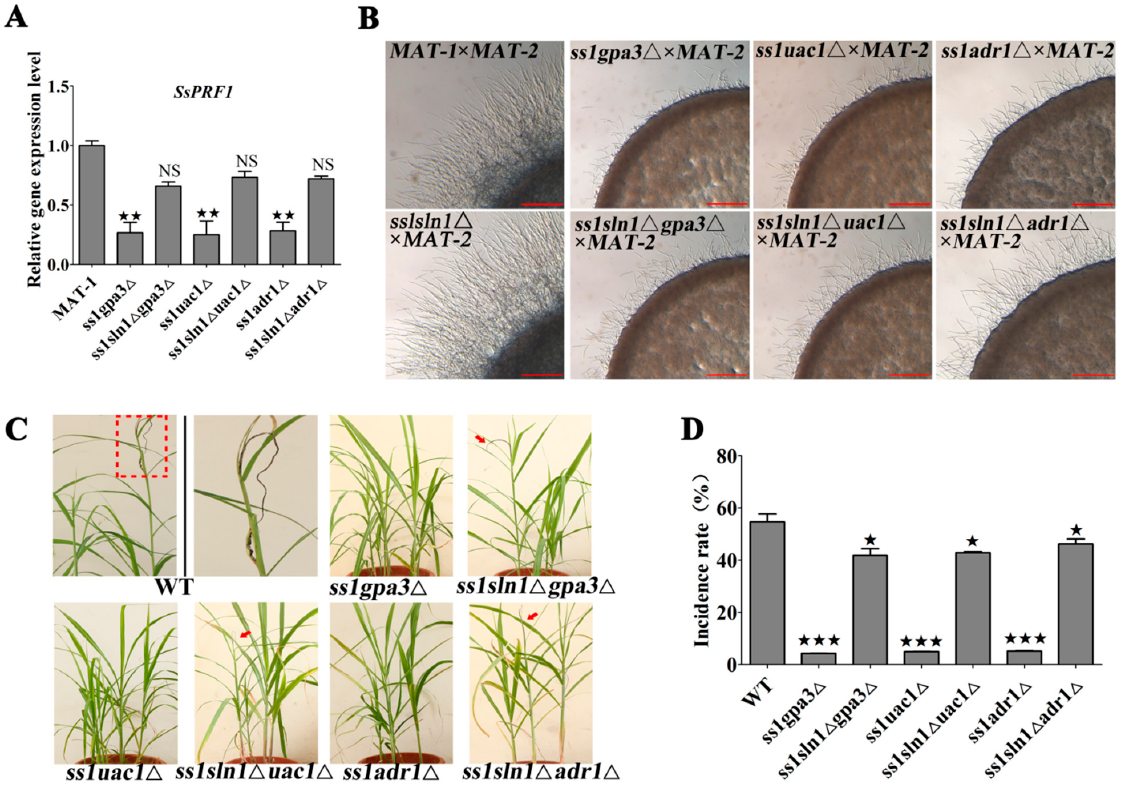
Figure 7. Effect of cross-talk between SsSln1 and cAMP/PKA pathway on mating and virulence. ( A ) Transcriptional profile of SsPRF1 gene in the MAT-1 and mutants. The RT-qPCR assay was performed to assess the expression of SsPRF1 gene in MAT-1 , ss1gpa3 Δ , ss1sln1 Δ gpa3 Δ , ss1uac1 Δ , ss1sln1 Δ uac1 Δ , ss1adr1 Δ , and ss1sln1 Δ adr1 Δ strains under sporidial growth on YePSA plate for 30 h, respectively. The relative gene expression was calculated by following the - ΔΔ Ct method with ACTIN as an internal control. Bar chart depicts the statistical difference among the mean values ( ★★ p < 0.01). The NS represents no significance. Mean ± S.E. were derived from three independent biological repeats with three replications. ( B ) Mating assay of mutants. Sporidia from MAT, ss1sln1 Δ , ss1gpa3 Δ , ss1sln1 Δ gpa3 Δ , ss1uac1 Δ , ss1sln1 Δ uac1 Δ , ss1adr1 Δ and ss1sln1 Δ adr1 Δ strains were separately mixed with MAT-2 sporidia of equal volume and spotted onto minimal medium to incubate at 28 °C. Images were taken after 30 h of cultivation. Scale bar = 0.5 mm. ( C ) Pathogenicity assay of mutants. Sporidia from an equal volume of MAT-2 sporidia and inoculated into the sugarcane seedlings of variety ROC22. The infection assays were performed with at least 15 seedlings. The symptoms of ‘black whip’ were documented and photographed at about six months post inoculation. The red dotted box regions were enlarged for a better view of whip symptoms. The symptoms of ‘black whip’ are denoted by red arrows. ( D ) Bar chart depicts the quantification of infection as shown in ( C ). Percentage (%) (cid:70) p of ‘black whip’/total seedlings is indicated. Bar chart depicts the statistical difference among the mean values ( < 0.05, (cid:70)(cid:70)(cid:70) p < 0.001). Mean ± S.E. were derived from two independent biological repeats with three